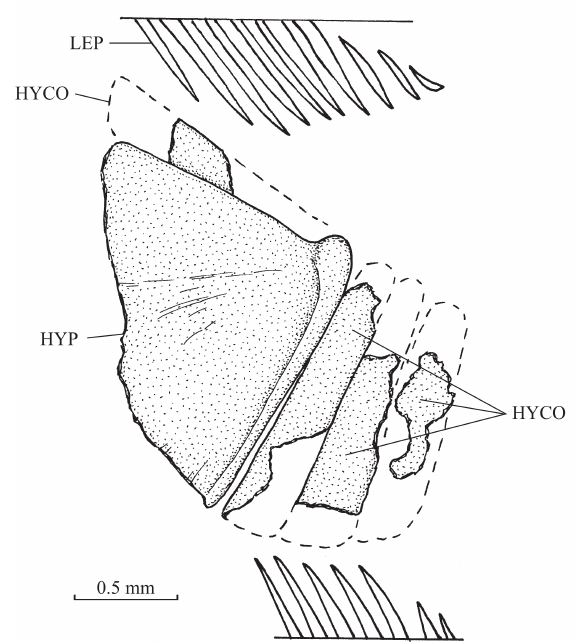
Fig. 20. Pankowskichthys libanicus gen. et sp. nov. Caudal skeleton of holotype, IRSNB P